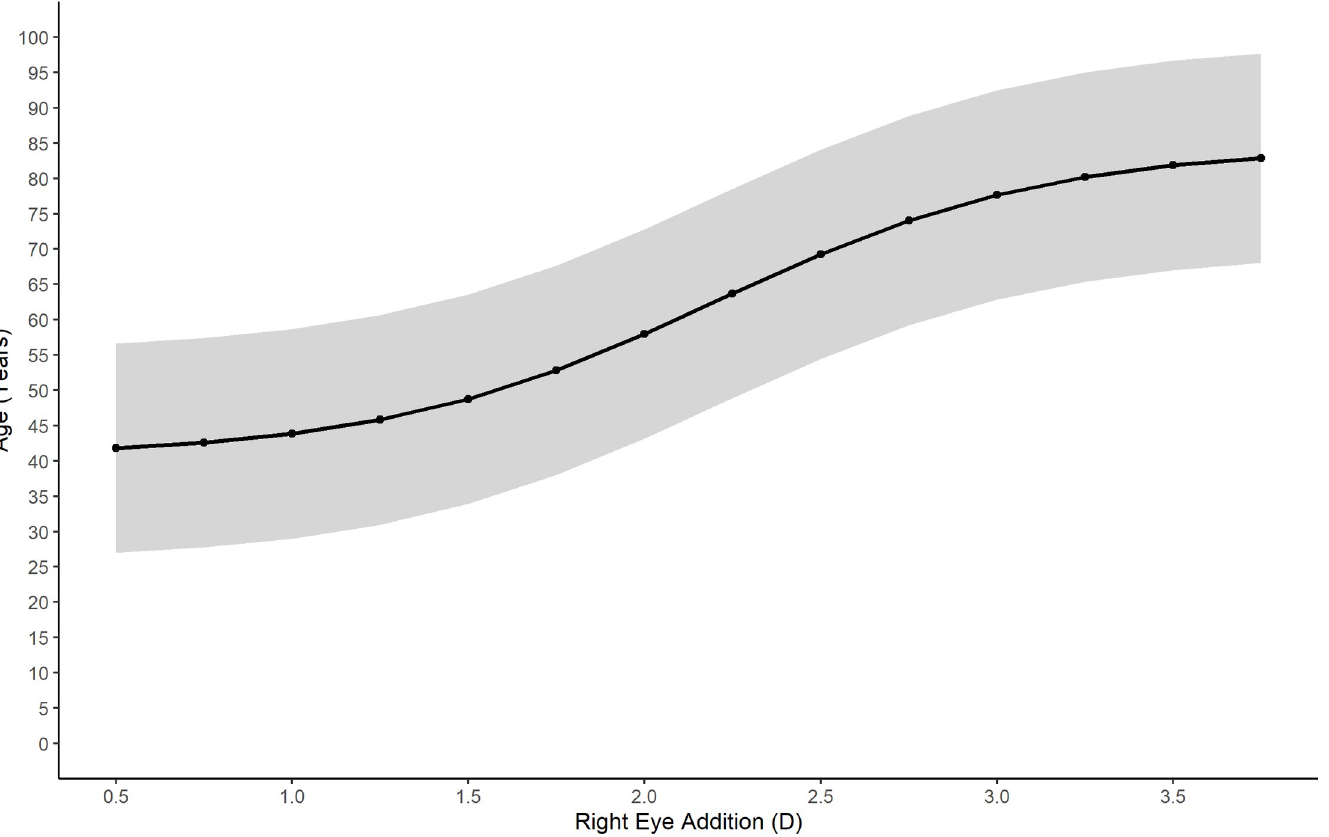
Fig 4. Predicted age based on the prescribed reading addition for EMR patients with 95% prediction intervals.